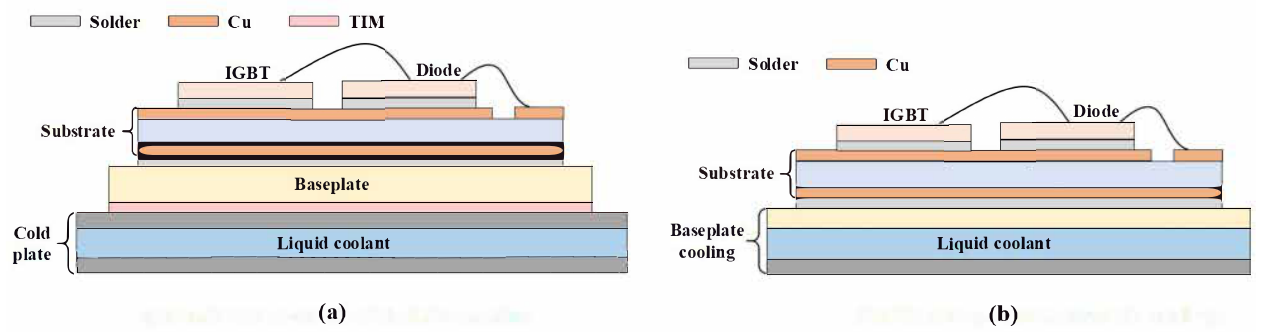
Figure 4. Schematic of ( a ) indirect contact cold plate cooling and ( b ) direct contact baseplate